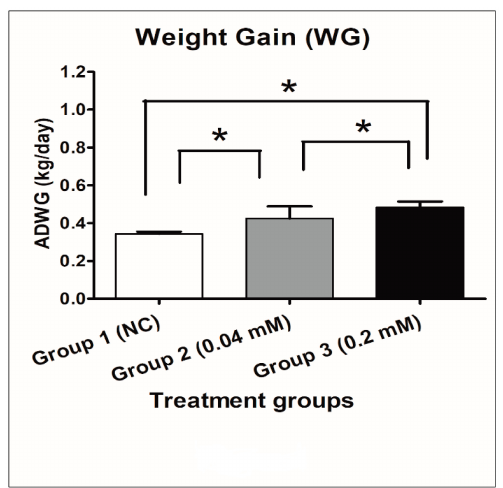
Figure 4. Assessment of average daily weight gain (ADWG). ADWG was calculated for the pigs in each group at 28 days and is expressed in kg/day. Asterisks indicate significant differences (* p < 0.05) in the ADWG of the pigs between groups.